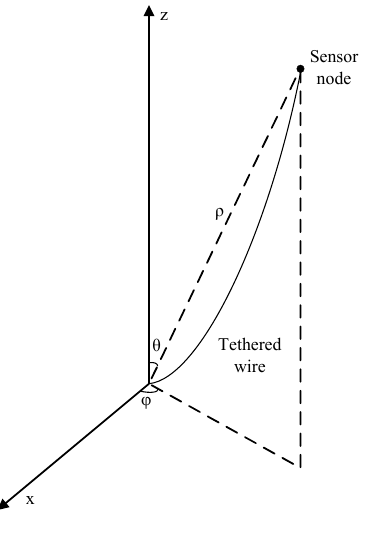
Figure 2. Movement model of sensor